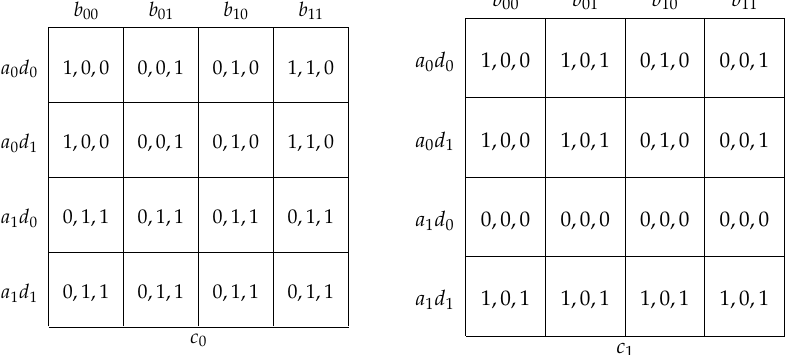
Figure 2. The strategic form game associated with the extensive-form game in Figure